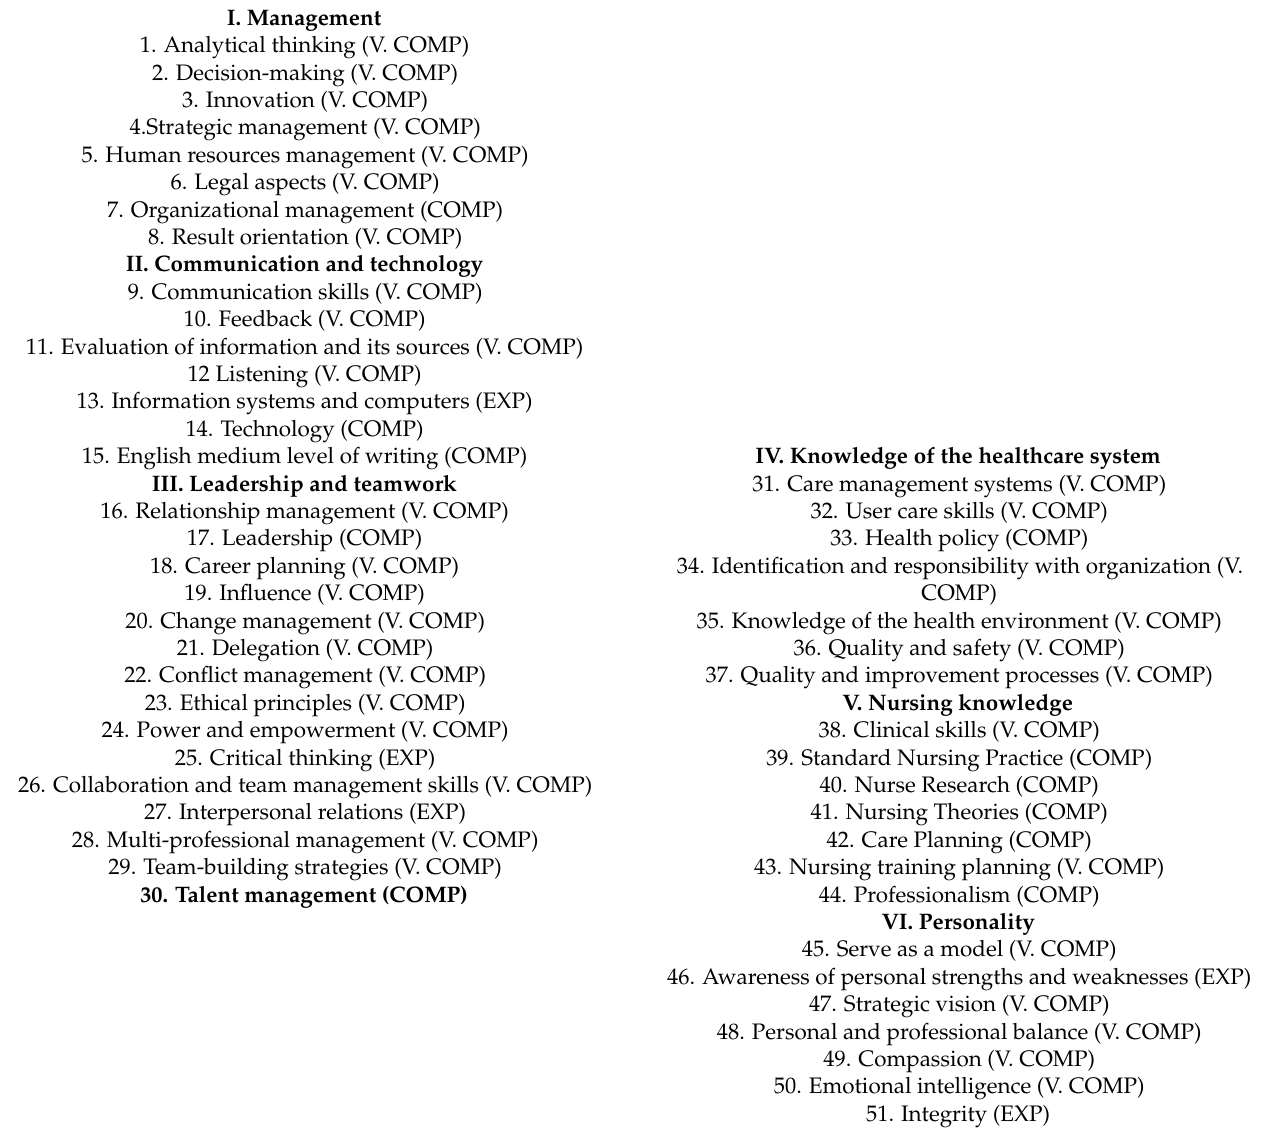
Table 2. Model of competencies for a middle nurse